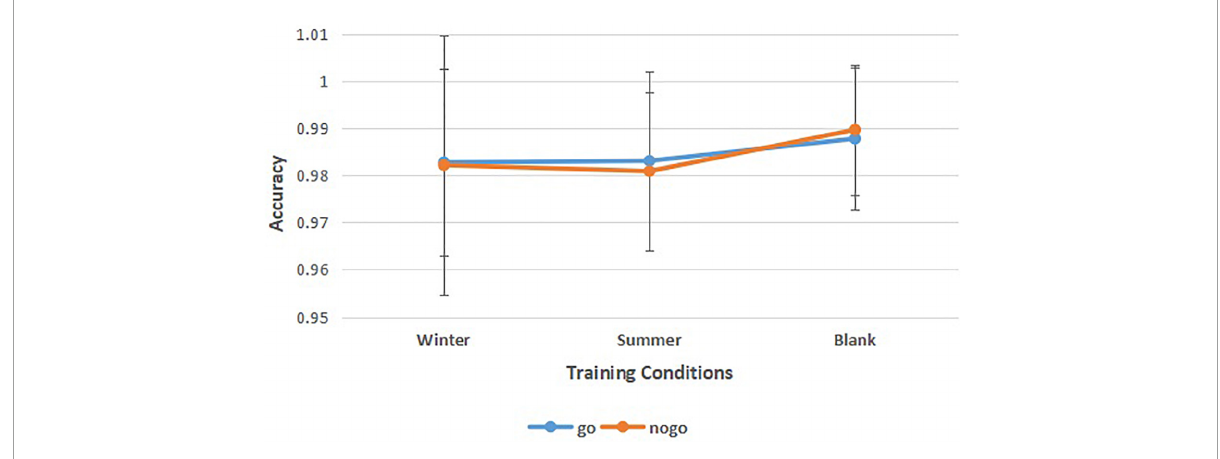
FIGURE4 Means of accuracy of go tasks and no-go tasks in three training conditions. Error bars represent the standard deviation.